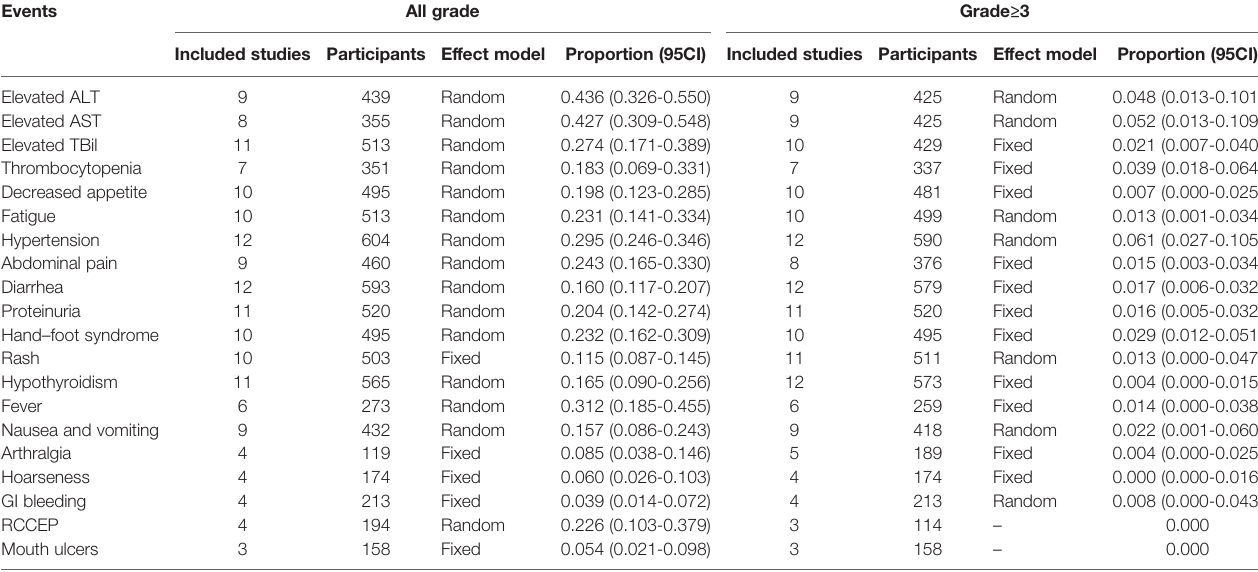
TABLE 6 | Treatment-related adverse events of triple